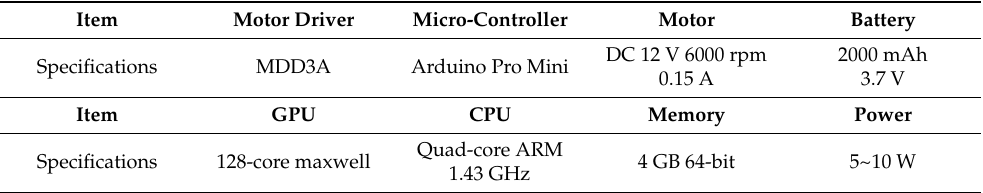
Table 1. Specifications of items used for simulation and Jetson Nano Developer kit.